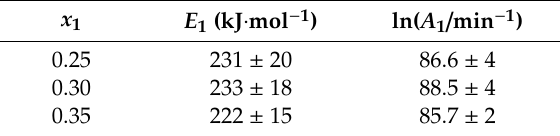
Table 4. The activation energies and the pre-exponential factors for the process of disruption of the tertiary structure of lysozyme in the DMSO–water mixtures with a di ff erent mole fraction of DMSO x 1